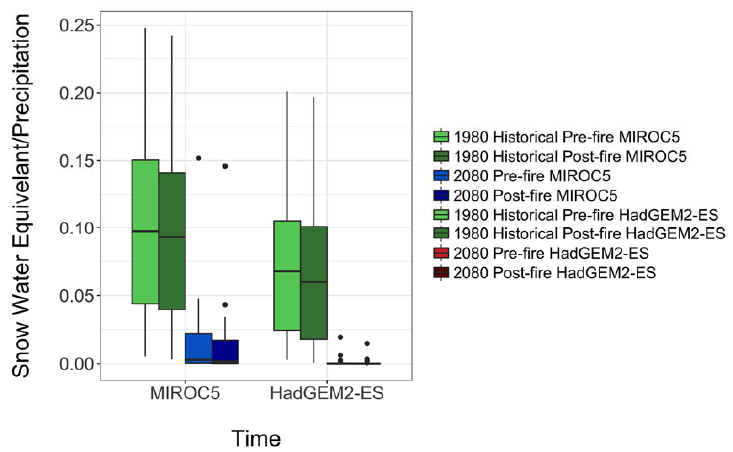
Figure 7. Ratio of snow water equivalent to precipitation for MIROC5 in RCP 4.5 and HadGEM2-ES in RCP 8.5 before and after forest cover reduction in comparison to historic conditions.